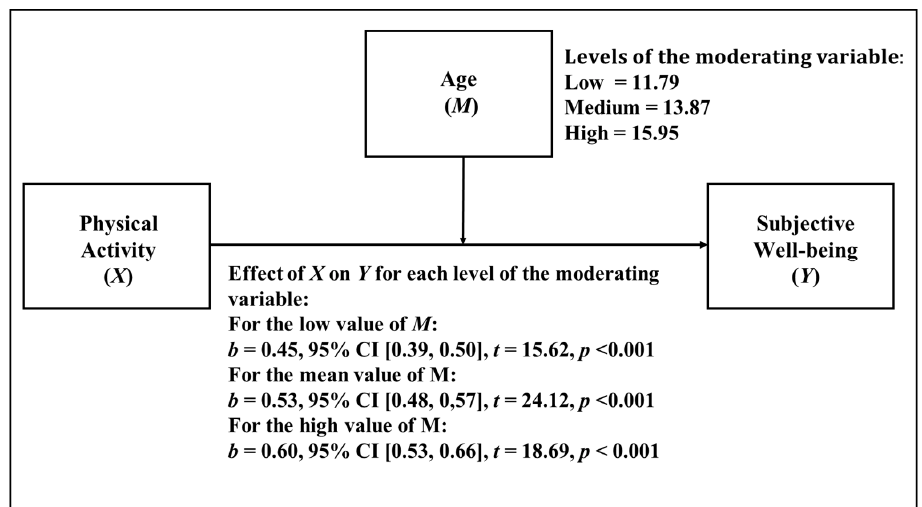
Figure 2. Simple moderation model in which age is considered as moderator. Table 4. Regression analysis of SWB on PA, considering the moderating effect of age.